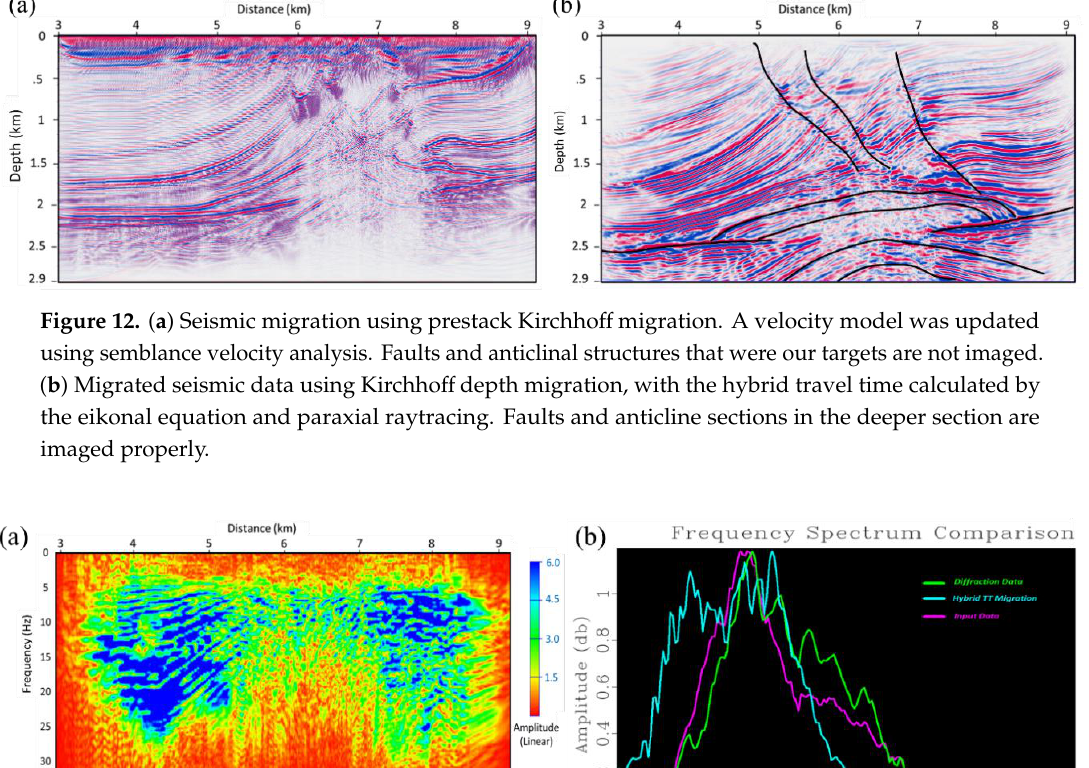
Figure 11. ( a ) Common Mid Point (CMP) stacked section after careful processing, including sorting of the gather data from the CMP gather data, amplitude correction, and NMO correction. ( b ) Diffraction section after application of dip frequency filtering with high amplitude display. Diffracted events are enhanced. ( c ) Difference or reflection section, showing that consideration of the diffraction is quite important for successful subsurface imaging, especially for faults and fractures.